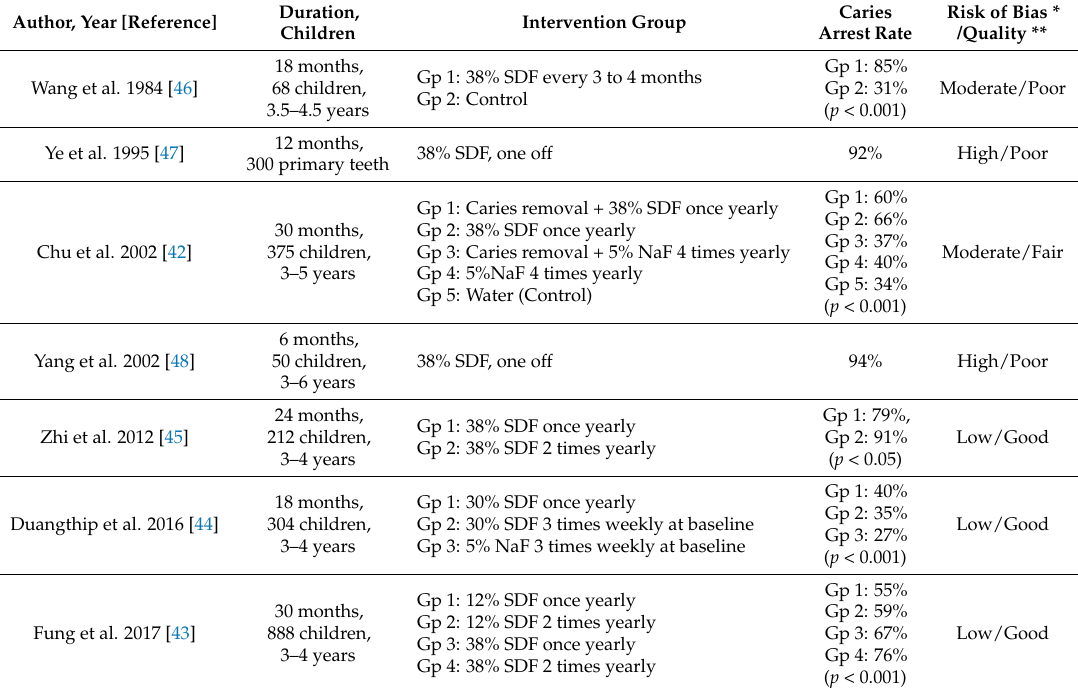
Table 2. Clinical trials of silver diamine fluoride (SDF) to arrest caries in young children in